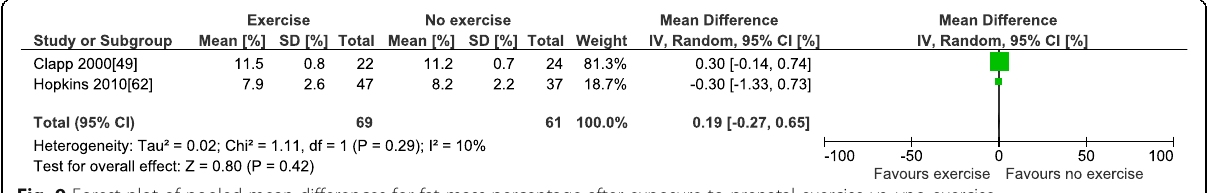
Fig. 9 Forest plot of pooled mean differences for fat mass percentage after exposure to prenatal exercise vs. vno